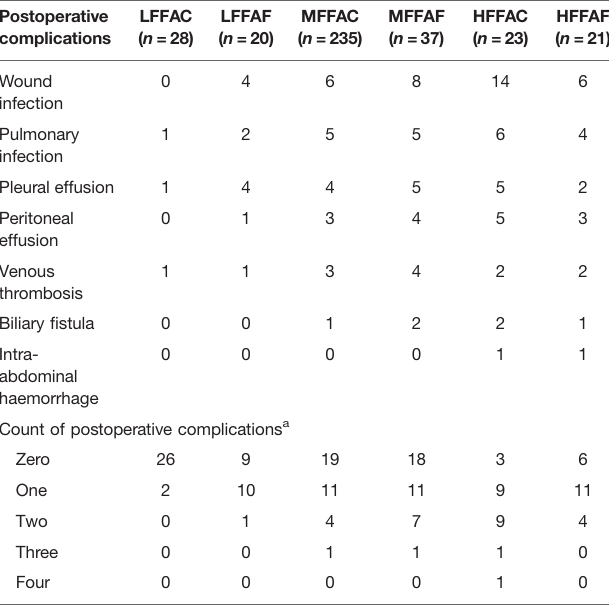
TABLE 2 | Postoperative complications of each group.